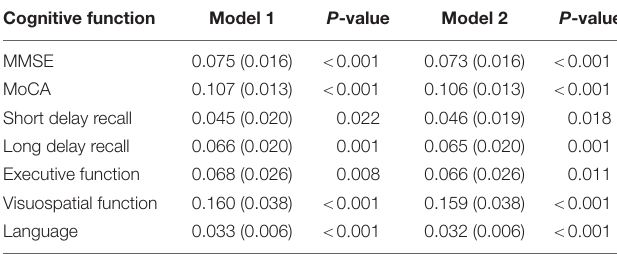
TABLE 1 | Characteristics of the study participants. TABLE 2 | Association of olfactory identification with cognitive